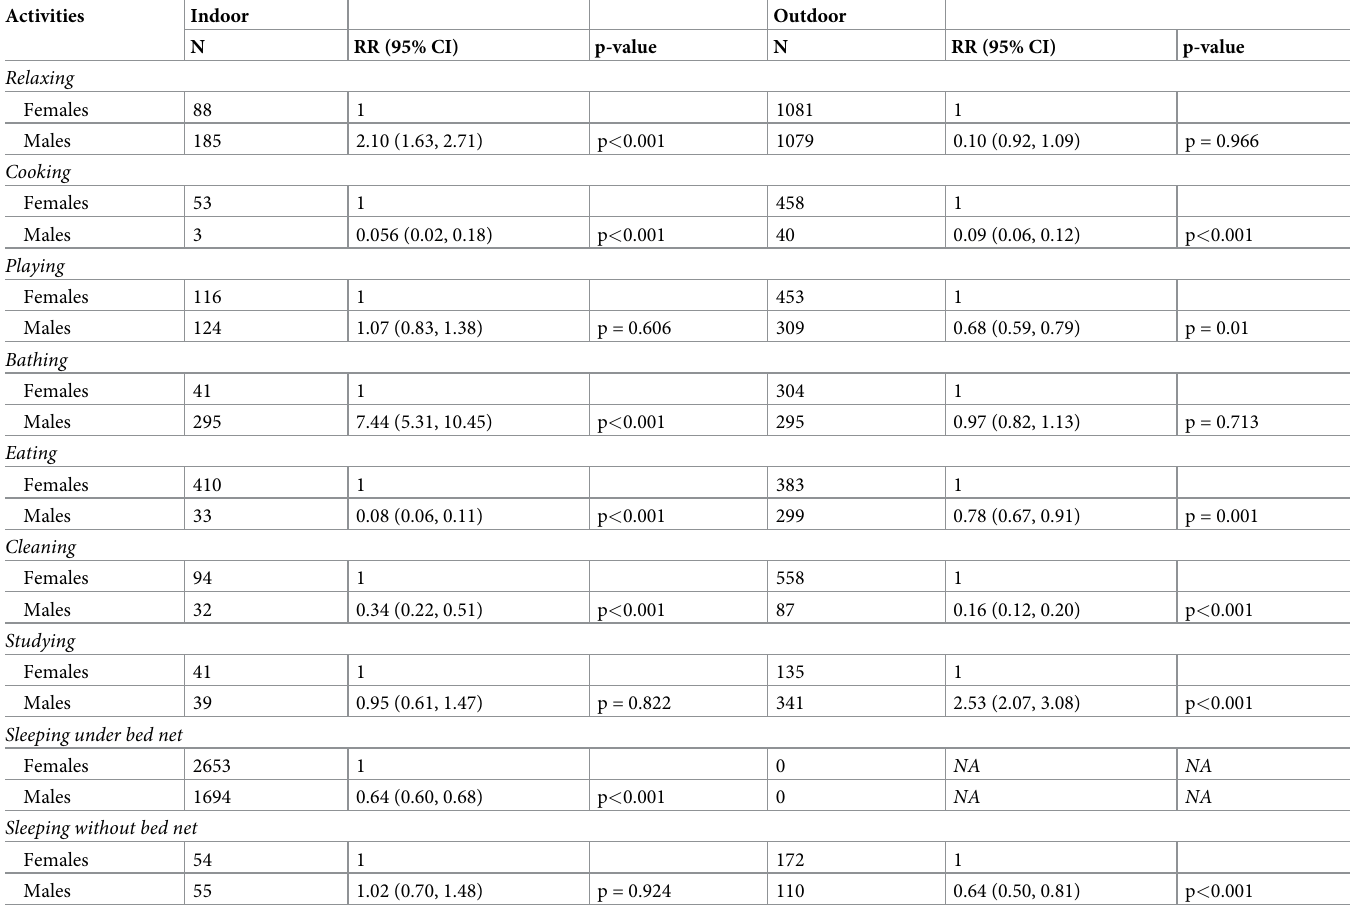
Table 2. Gender differences in in the popular peri-domestic activities observed among household members of 6 years and